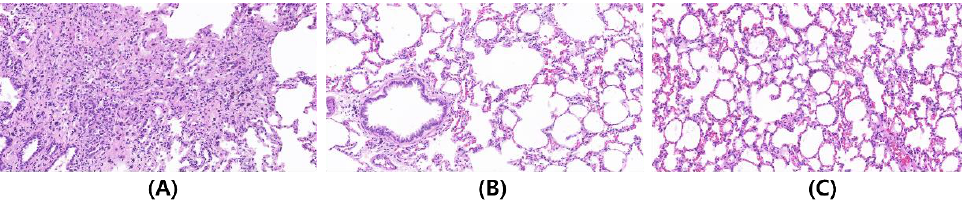
Figure 5. Histopathological analysis of lungs in each group. ( A ) A histopathological section of a rat lung treated with PHMG shows inflammatory cells infiltrating fibrosis (H&E, X200), ( B ) a tissue section of rat lung treated with PBS, which serves as a negative control (H&E, X200), ( C ) the control group, which did not receive any treatment (H&E, X200) in the rat